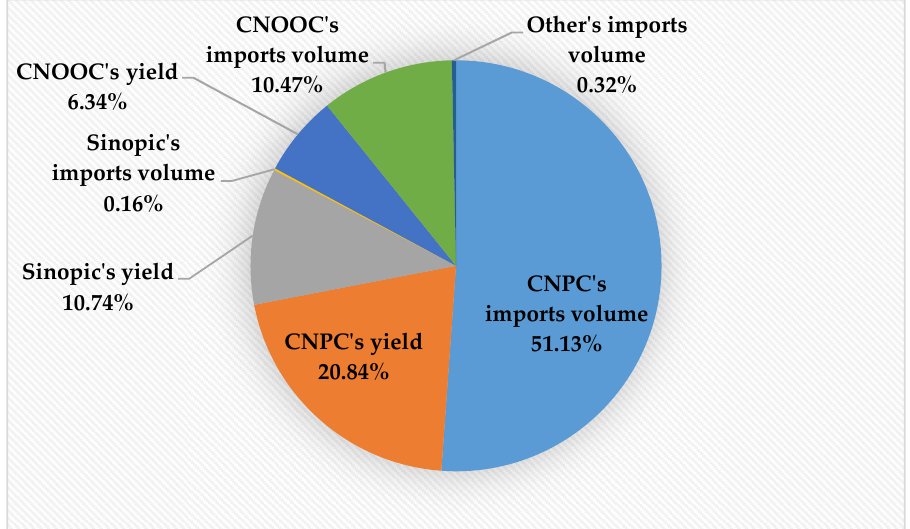
Figure 5. The major natural gas importers in China in 2013.